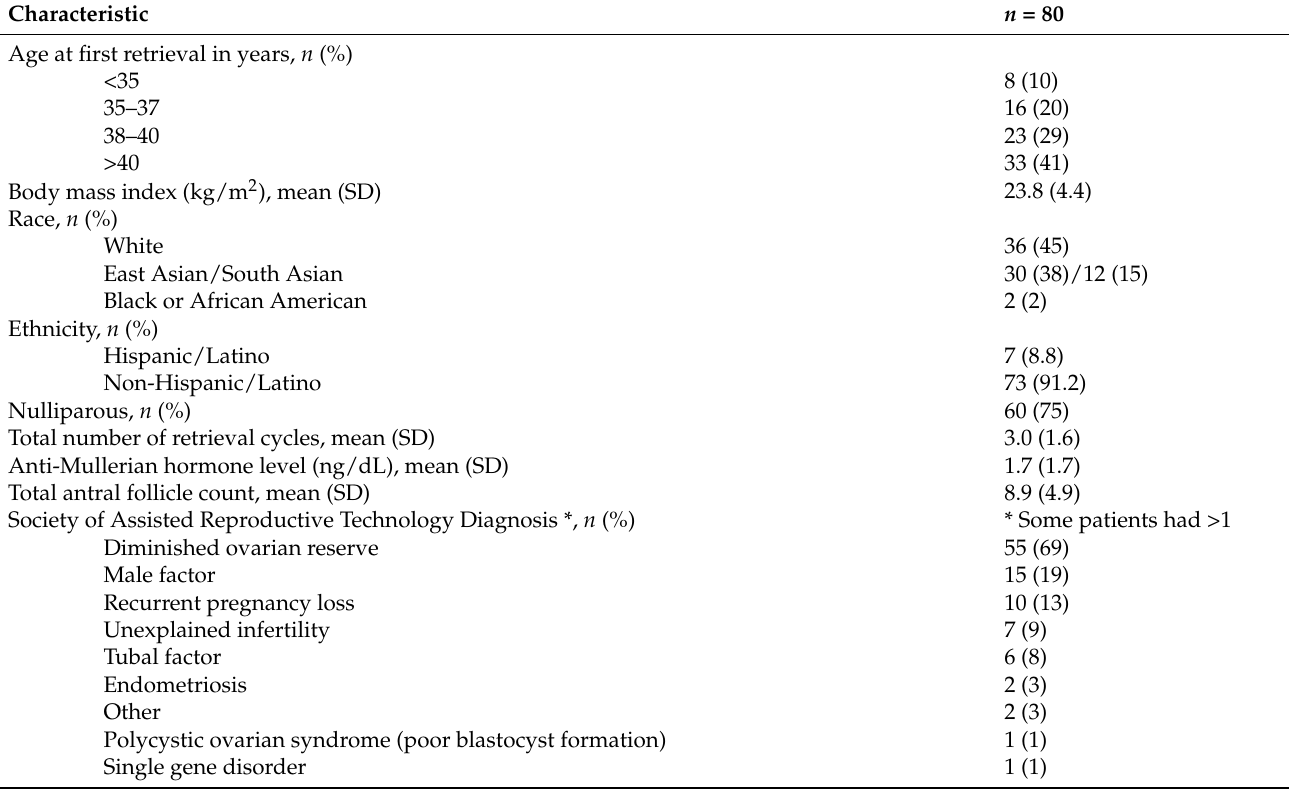
Table 1. Study cohort demographic and clinical